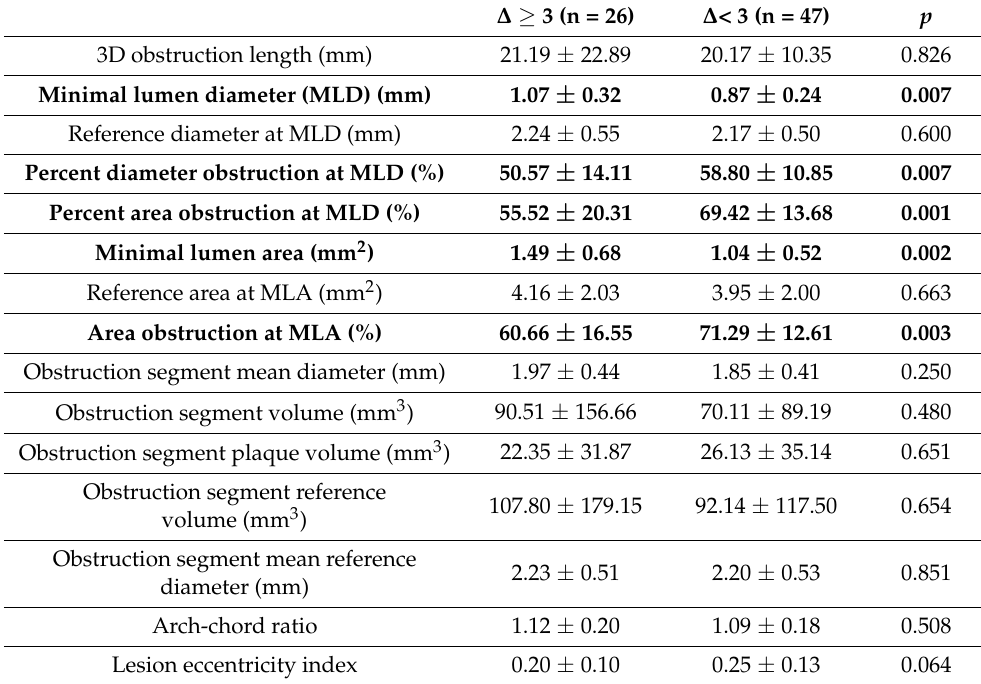
Table 6. 2/3D parameters in NSTEMI patients comparing TFC changes between ∆ ≥ 3 and ∆ < 3